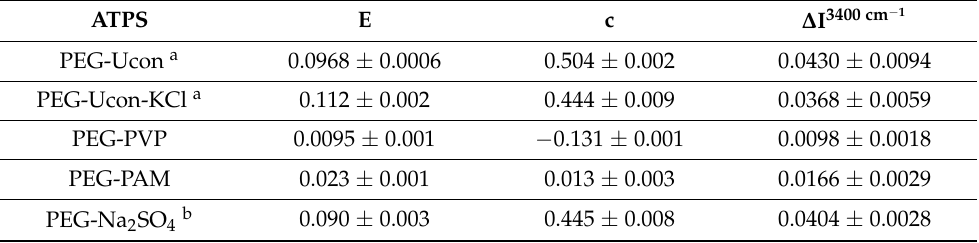
Figure 5. Logarithm of the partition coefficient, log K DNP-aa Na , value for sodium salts of DNP − amino acids with aliphatic side chains in aqueous two-phase systems indicated as a function of equivalent length of the side chain, N C , expressed in terms of the equivalent number of CH 2 units. Table 1. Solvent properties of studied aqueous two-phase